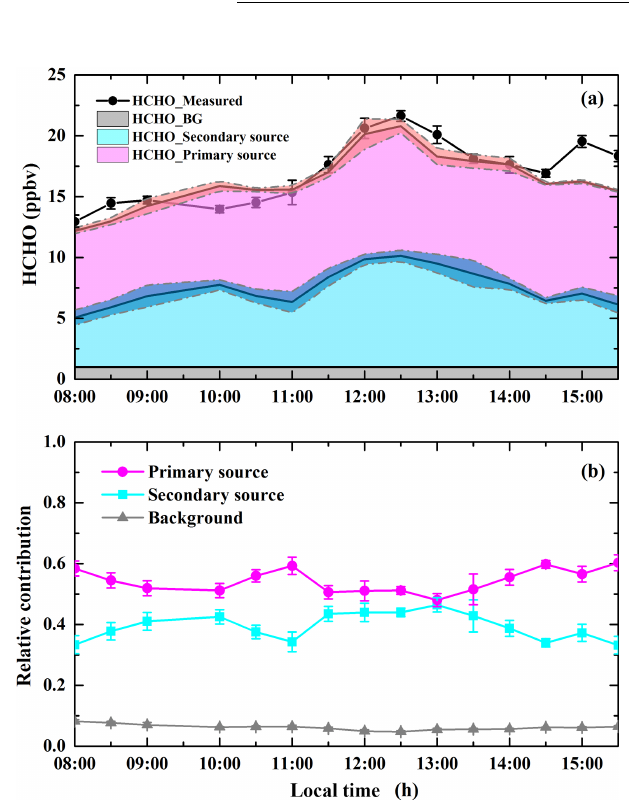
Figure 13. Time series of absolute (a) and relative (b) contribution of the primary source, secondary source, and atmospheric back- ground to ambient HCHO levels on 3 December 2015. The error bars refer to the 1 σ of the absolute ( a , error bars with fill area) and relative (b) contribution of the primary source, secondary source, and atmospheric background to ambient